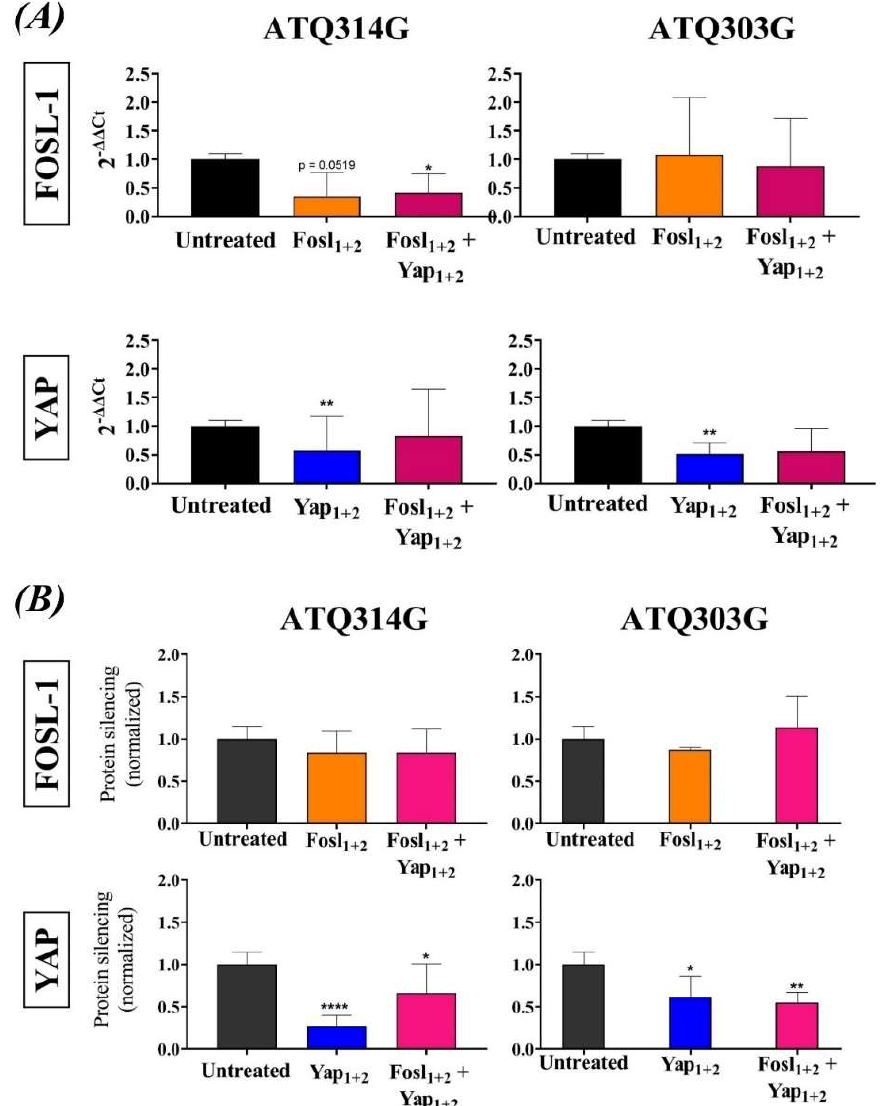
Figure 4. In vitro silencing efficacy of lipoplexes in ATQ314G and ATQ303G cells after 72 h of incubation with the different lipoplexes at charge ratio ( ± ) 15 and 50 nM siRNA. ( A ) mRNA expression analysed by qRT − PCR of FOSL-1 and YAP using GAPDH as internal control and normalized to untreated cells. ( B ) Quantification of protein expression studied by Western blot using tubulin as control and normalized to untreated cells. In the graphs, the statistically significant differences between negative control and the different treatments were represented as: * p ≤ 0.05, ** p ≤ 0.01; **** p ≤ 0.0001. For original Western Blot, see Figures S1 and S2.